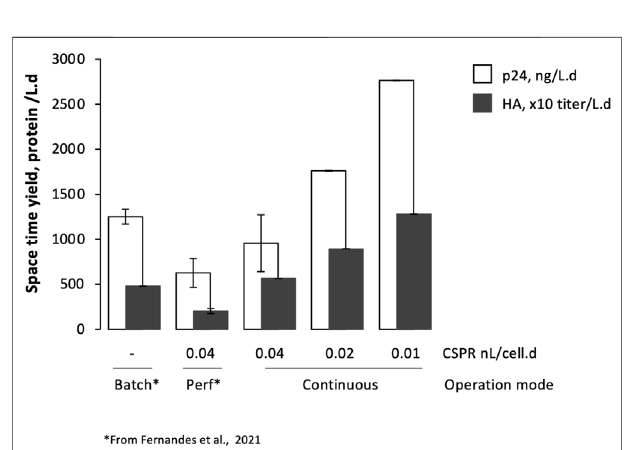
FIGURE 5 | Space-time yield of Gag-HA VLPs produced using stable adapted Sf9 cells at different bioreactor operation modes and cell-speci fi c perfusion rates. Data from batch and perfusion mode have been reported elsewhere (Fernandes et al., 2021).